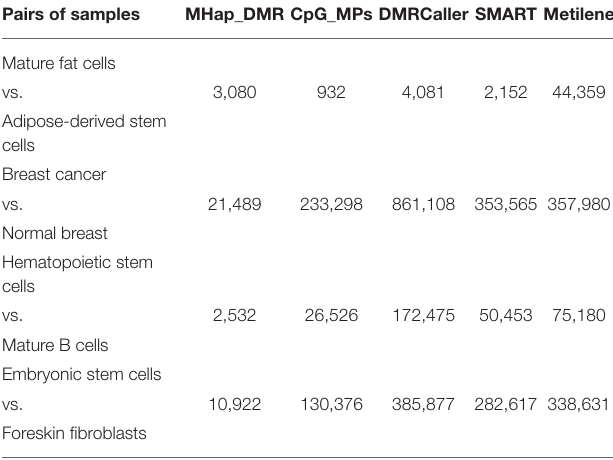
TABLE 4 | The number of DMRs identified by different methods. Pairs of